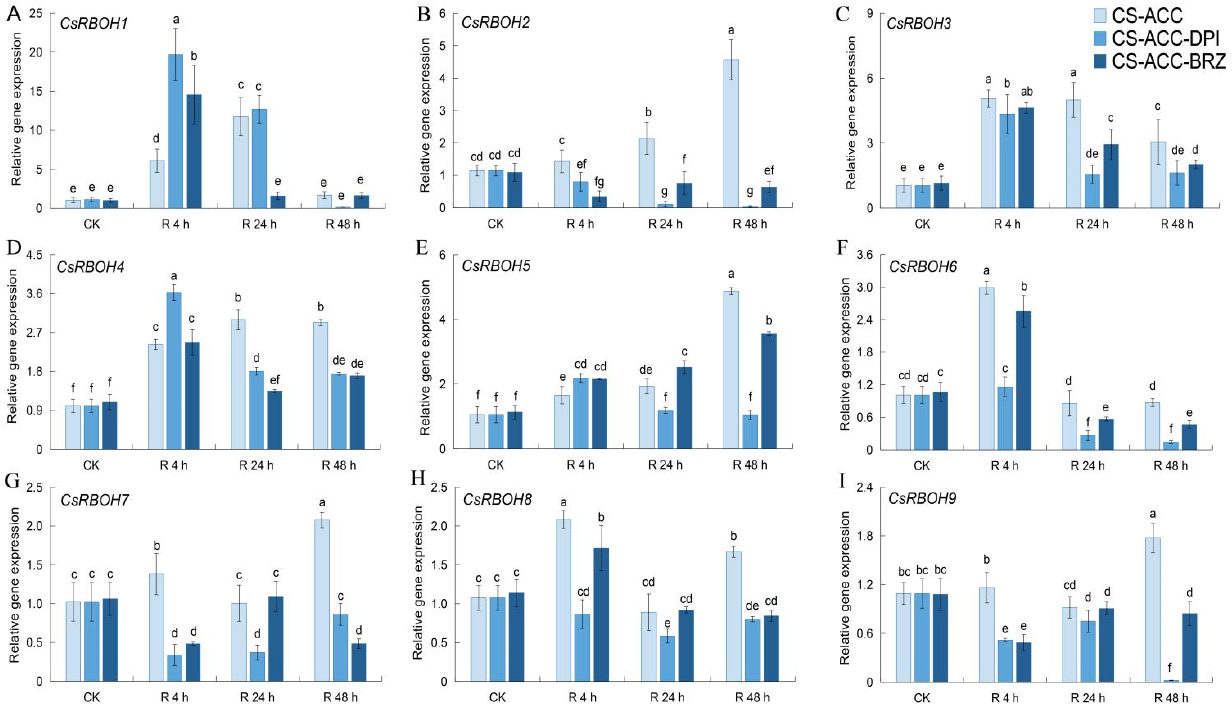
Figure 3. Inhibition of RBOH -dependent signaling or BRs during recovery after CS-ACC affected the expression of CsRBOH1 ( A ), CsRBOH2 ( B ), CsRBOH3 ( C ), CsRBOH4 ( D ), CsRBOH5 ( E ), CsRBOH6 ( F ), CsRBOH7 ( G ), CsRBOH8 ( H ) and CsRBOH9 ( I ), respectively. CK: control, cucumber seedlings with no acclimation and at 25 °C during recovery; CS-ACC: cucumber seedlings were treated with a cold stress regime of 10 °C for 1 h, 25 °C for 1.5 h, and 1 °C for 3 h; CS-ACC-DPI: diphenyleneiodonium (DPI) was sprayed onto the seedlings during recovery after CS-ACC; CS-ACC-BRZ: brassinozole (BRZ) was sprayed onto the seedlings during recovery after CS-ACC; R: recovery, 25 °C. The different letters indicate significant differences as assessed by Turkey HSD test ( p < 0.05; n ≥ 4).